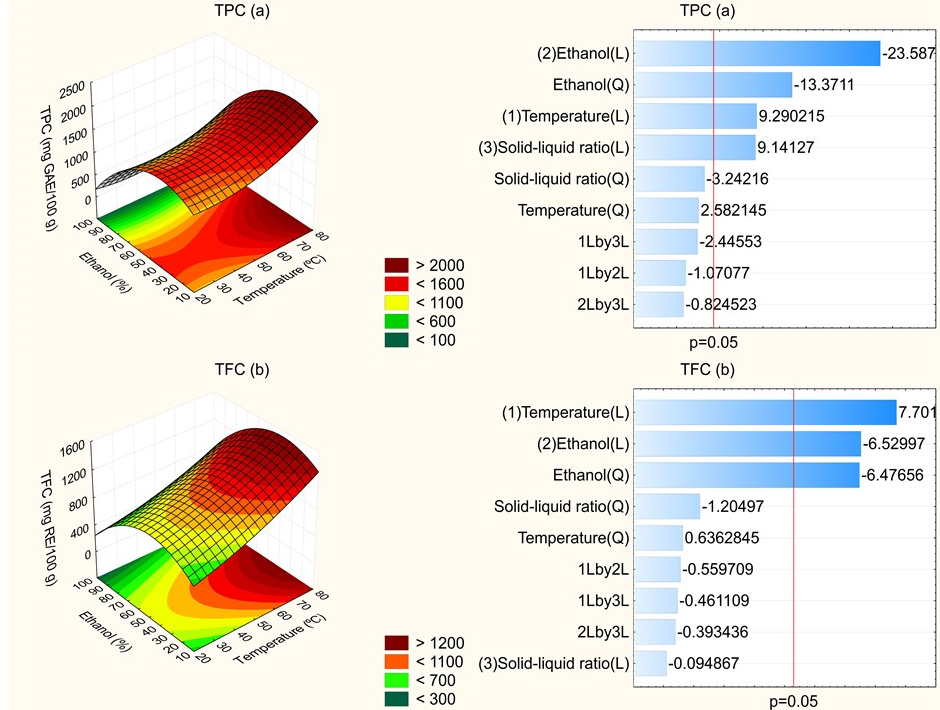
Figure 1. Effect of the independent variables on the total phenolic compounds (TPC) ( a ), total flavonoid compounds (TFC) ( b ).